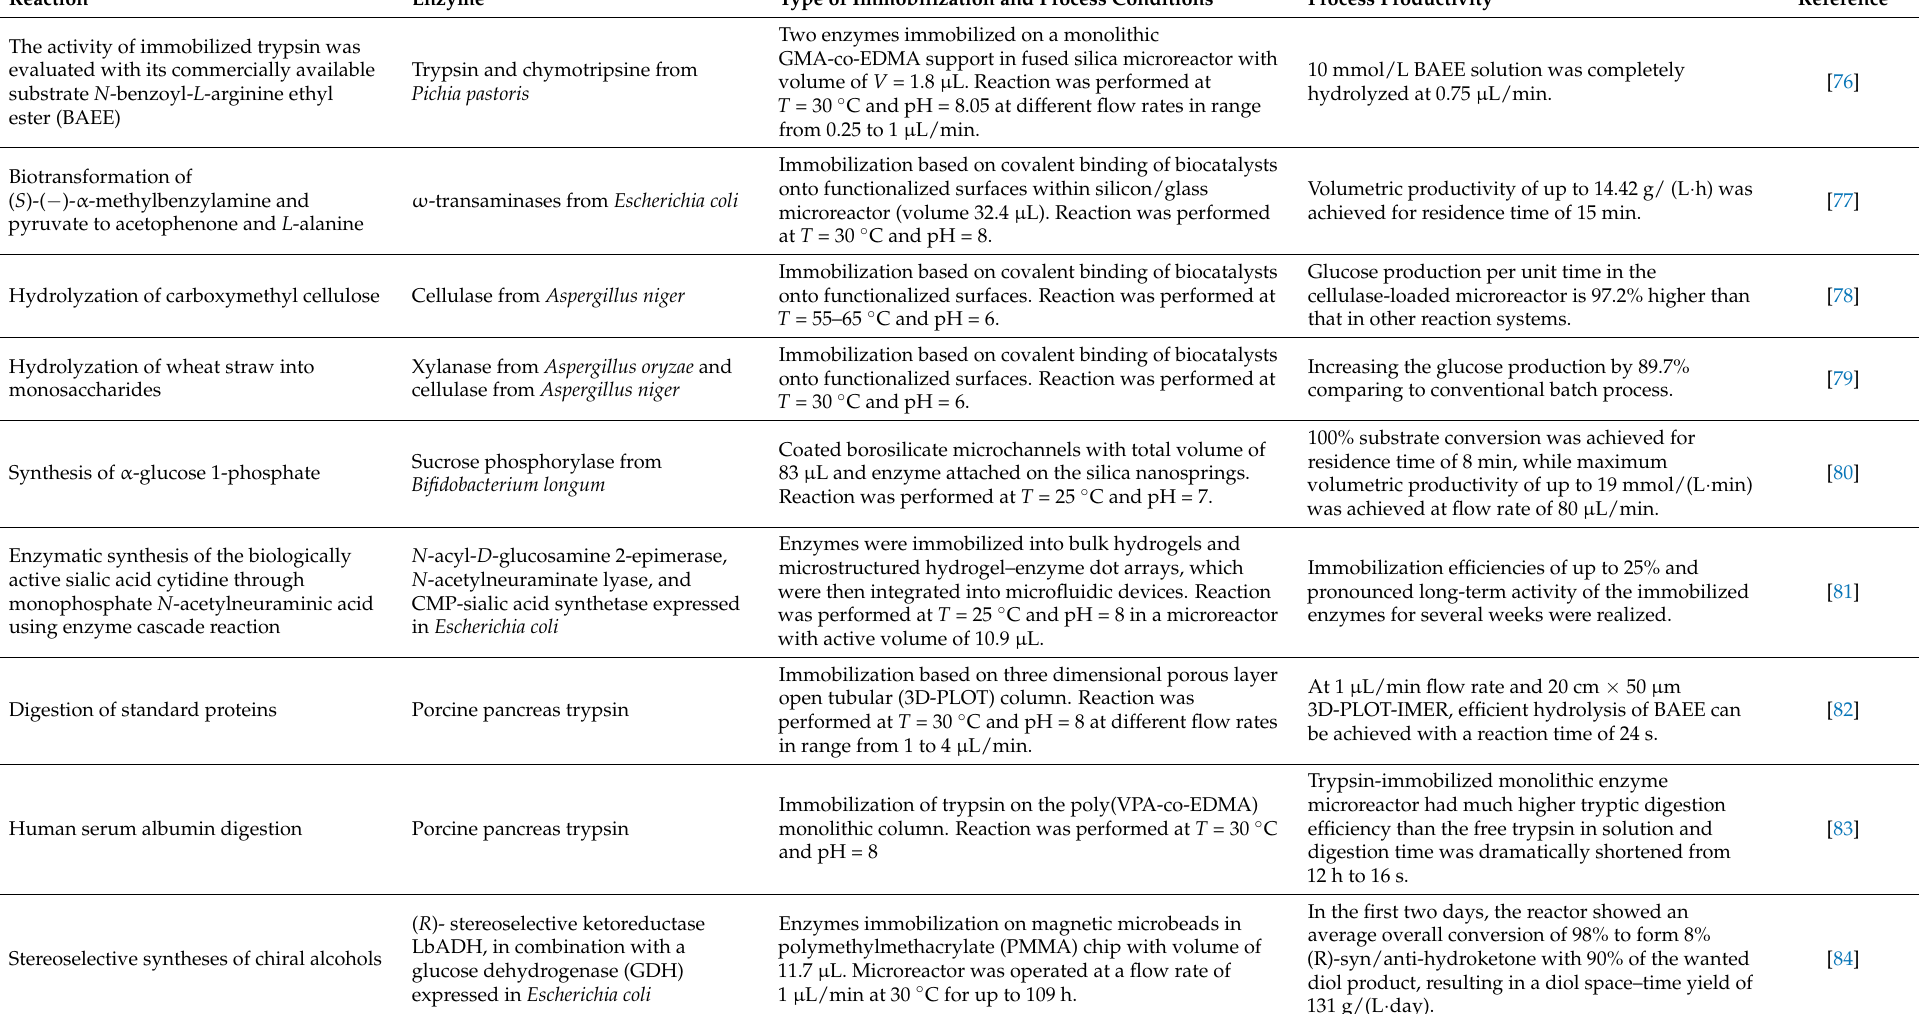
Table 2. Application of microreactors for biotransformations with immobilized